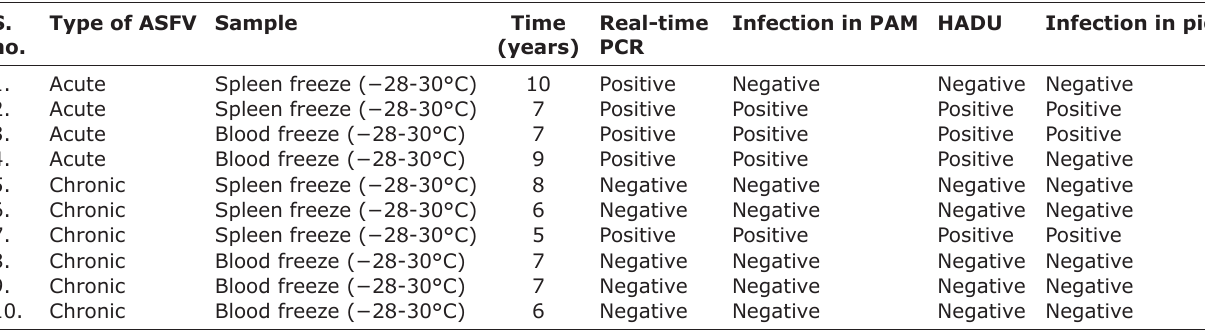
Table-2: Surviving of ASFV in freeze conditions. S. Type of ASFV Sample Time no.